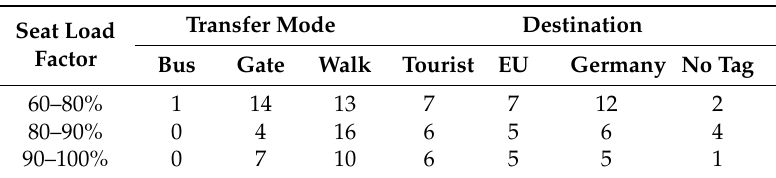
Table 4. Flight categorization.